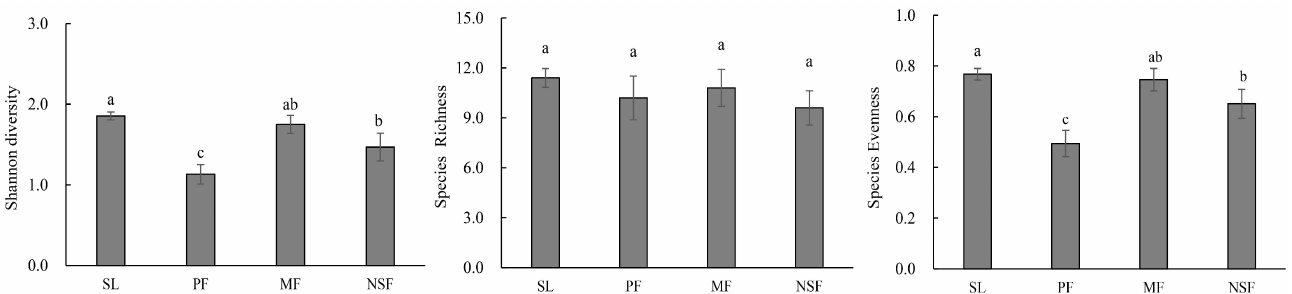
Figure 1. Species diversity (Shannon diversity, species richness, and species evenness) in the four veg- etation restoration types. The error bars represent the standard deviation of the mean. Different letters represent significant differences at the 0.05 level.